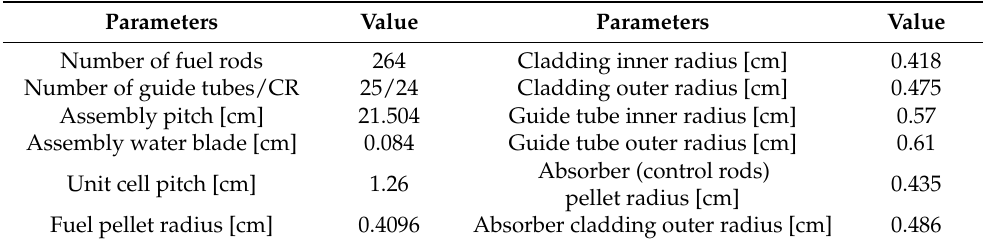
Figure 3. 32 FA PWR minicore layout. Reflector models: ( a ) radial reflector; ( b ) axial lower reflector; ( c ) axial upper reflector. Table 2. 32 FA PWR minicore: FAs and CRs Table 1. 32 FA PWR minicore layout and conditions.